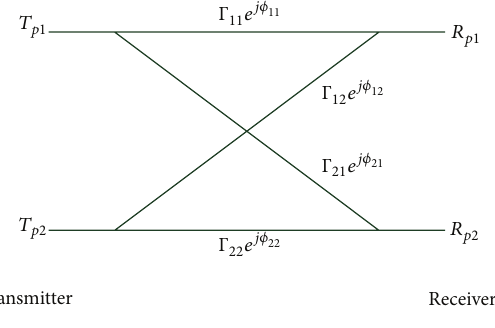
Figure 4: Transmission channel